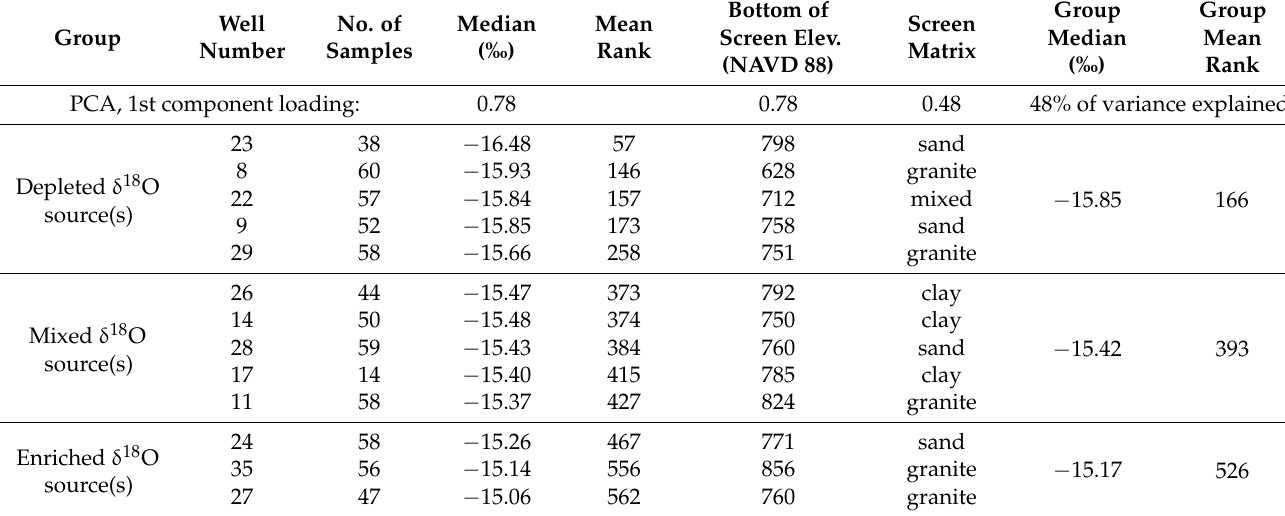
Table 2. Groundwater groupings based on an interpretation of median δ 18 O values and mean rank of the distribution of δ 18 O values by well location.